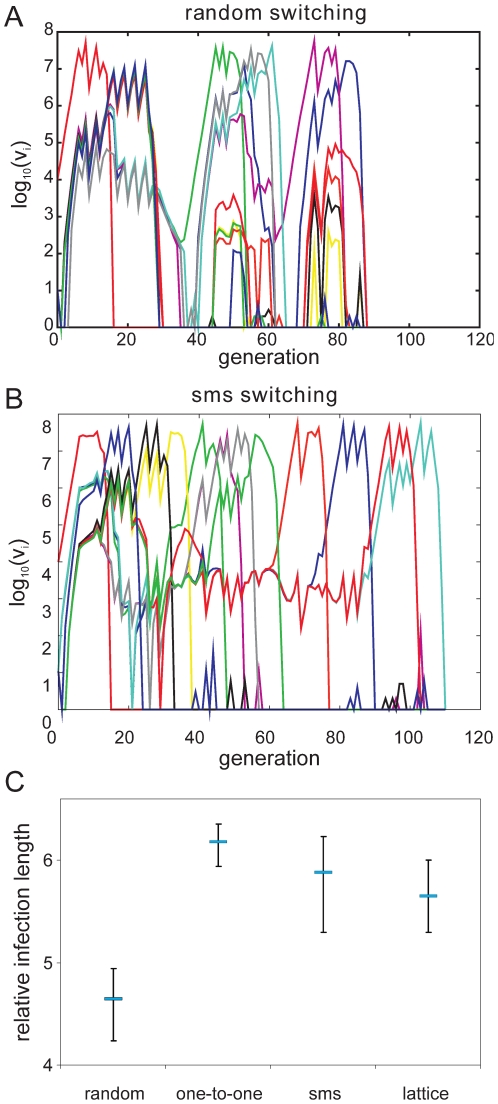
Effects of switching pattern on malaria infection
dynamics.Simulating malaria infections in the naïve host, here shown as
parasitaemia levels of the various antigenic variants under two
different assumptions about the nature of switching, does not reveal
major qualitative differences between random and preferential
switching (A and B, respectively). However, a marked increase in
infection length, as measured in multiples of a single variant
infection, can be observed once switching is more structured (C).
Shown are the median (blue bars) and lower and upper quartiles of
500 model realisations.